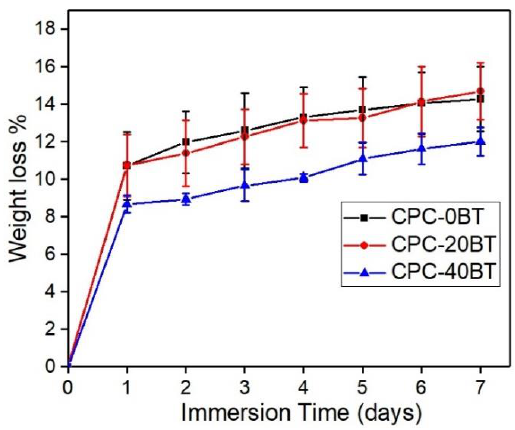
Figure 8. Weight loss% of CPC-x BT samples in 1.5 × t-SBF at different points of time.